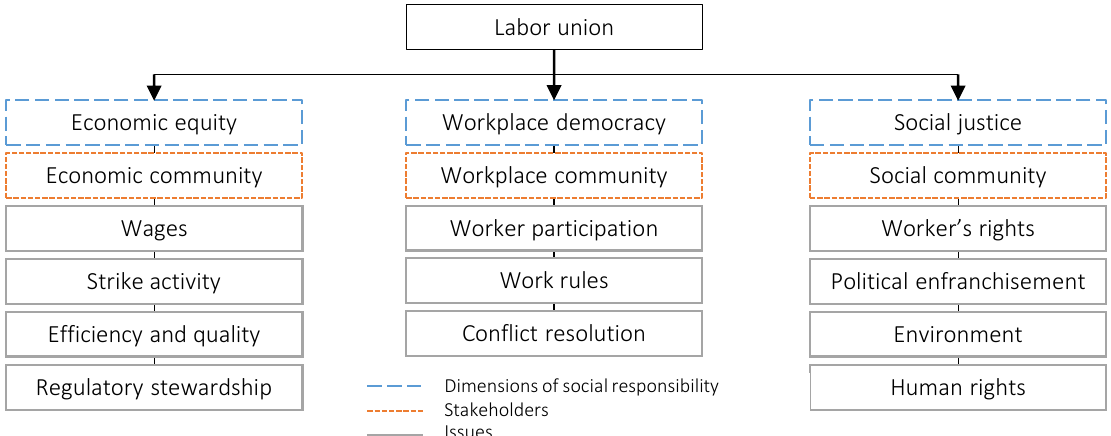
Figure 1. The role of labor union in communication with employees